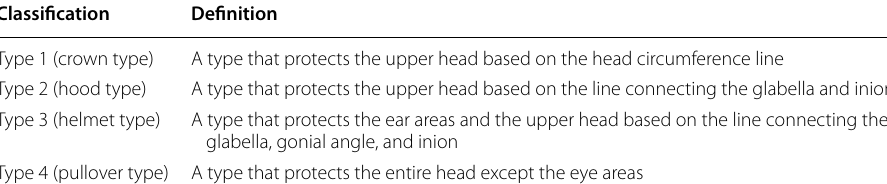
Table 11 Classification of hat types according to degree of head cover